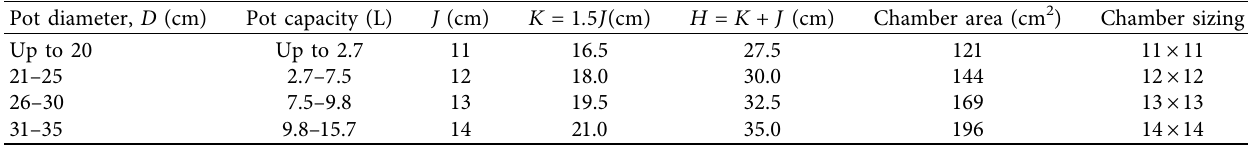
Table 1: Relationship between saucepan/pot diameter and combustion chamber.